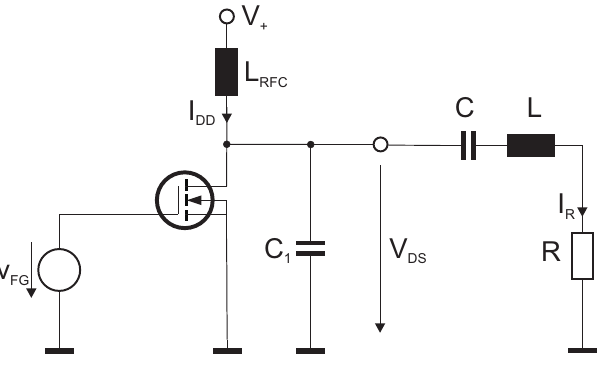
Figure 5. Most basic circuit for the class-E